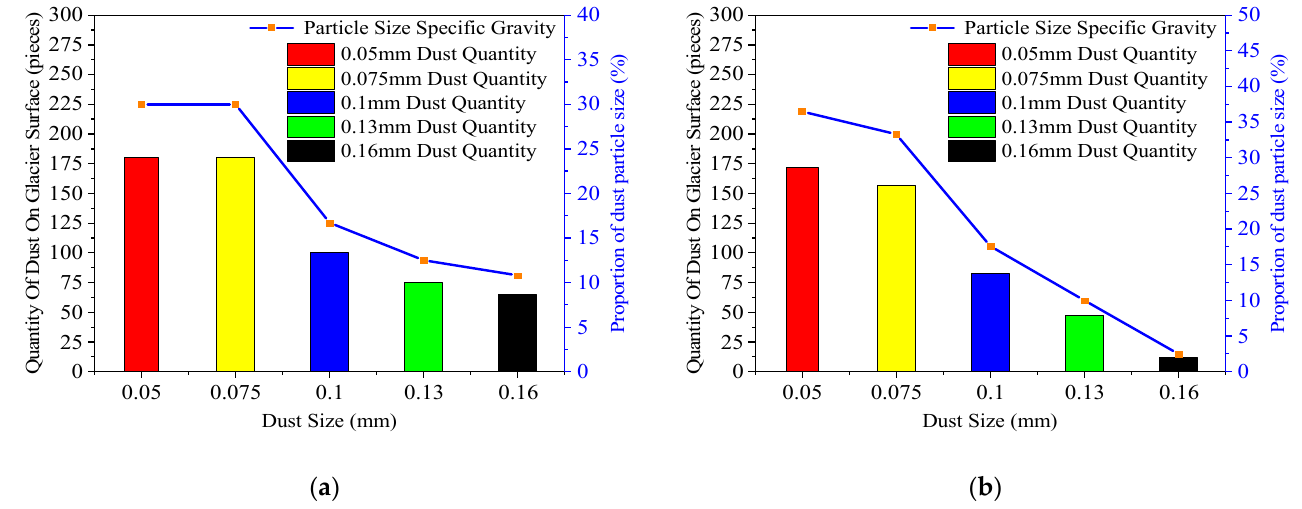
Figure 12. Number and proportion of the dust particle sizes in ( a ) winter and ( b ) summer.